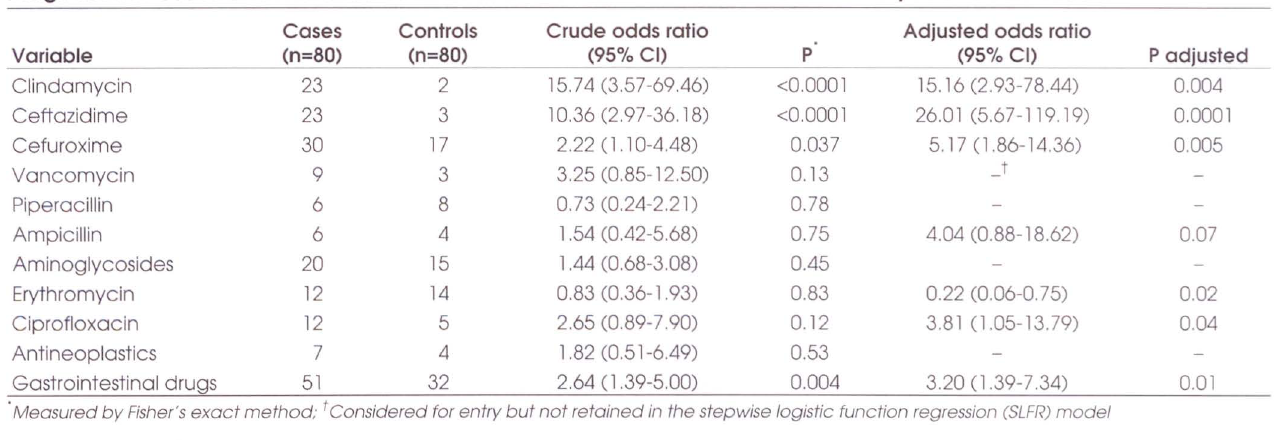
Drugs used in cases and matched controls and relative risks in the univariate analysis and SLFR model